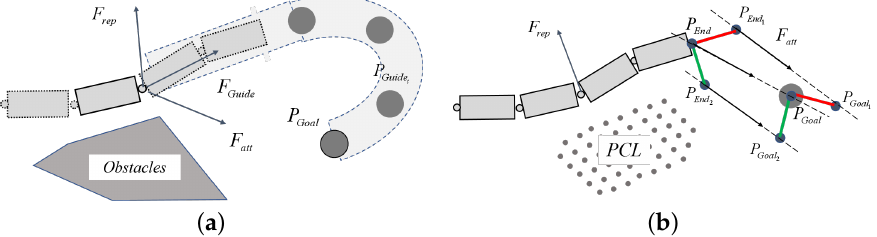
Figure 5. Force analysis diagram in two kinds of APF: ( a ) APF with guiding potential field; ( b ) Sim- plified and modified